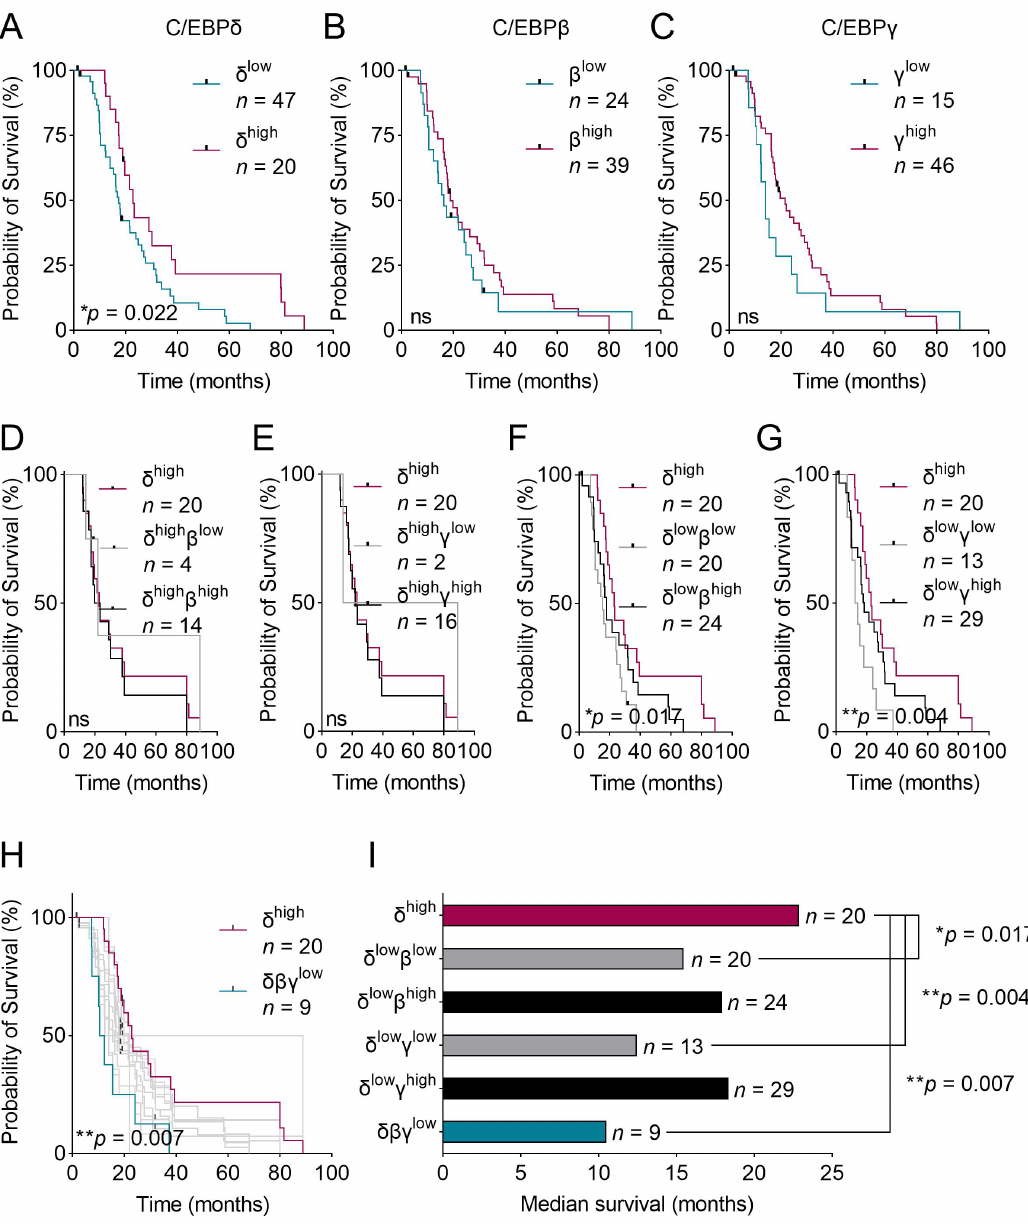
Figure 3. Kaplan–Meier curves of patients expressing various levels of C/EBP-proteins and those combinations. ( A – C ) Kaplan–Meier curves of patients with either high or low expression of ( A ) C/EBP δ , ( B ) C/EBP β and ( C ) C/EBP γ . ( D – G ) Kaplan–Meier curves of patients with high C/EBP δ (red curve) as well as patients with ( D ) high C/EBP δ with low C/EBP β (gray line) and high C/EBP δ with high C/EBP β (black line), ( E ) high C/EBP δ with low C/EBP γ (gray line) and high C/EBP δ with high C/EBP γ (black line), ( F ) low C/EBP δ with low C/EBP β (gray line) and low C/EBP δ with high C/EBP β (black line), ( G ) low C/EBP δ with low C/EBP γ (gray line) and low C/EBP δ with high C/EBP γ (black line). p -values correspond to the survival difference measured between patients with the best survival, i.e. high C/EBPδ (red line) and patients expressing low C/EBPδ with either low C/EBPβ ( F ) or low C/EBPγ ( G ) (gray lines). ( H ) Panel H combines survival curves of all patient groups discussed in panels ( A – G ). p -value compares the survival of patients with high C/EBP δ expression (red curve) with patients having low expression of all three proteins (turquoise curve). ( I ) Plotted is the median survival of the same patient groups as shown in panels ( F , G ) and of patients with low expression of all three proteins. Log-rank tests were used to estimate the effect of protein expression levels on survival. ns = not significant.